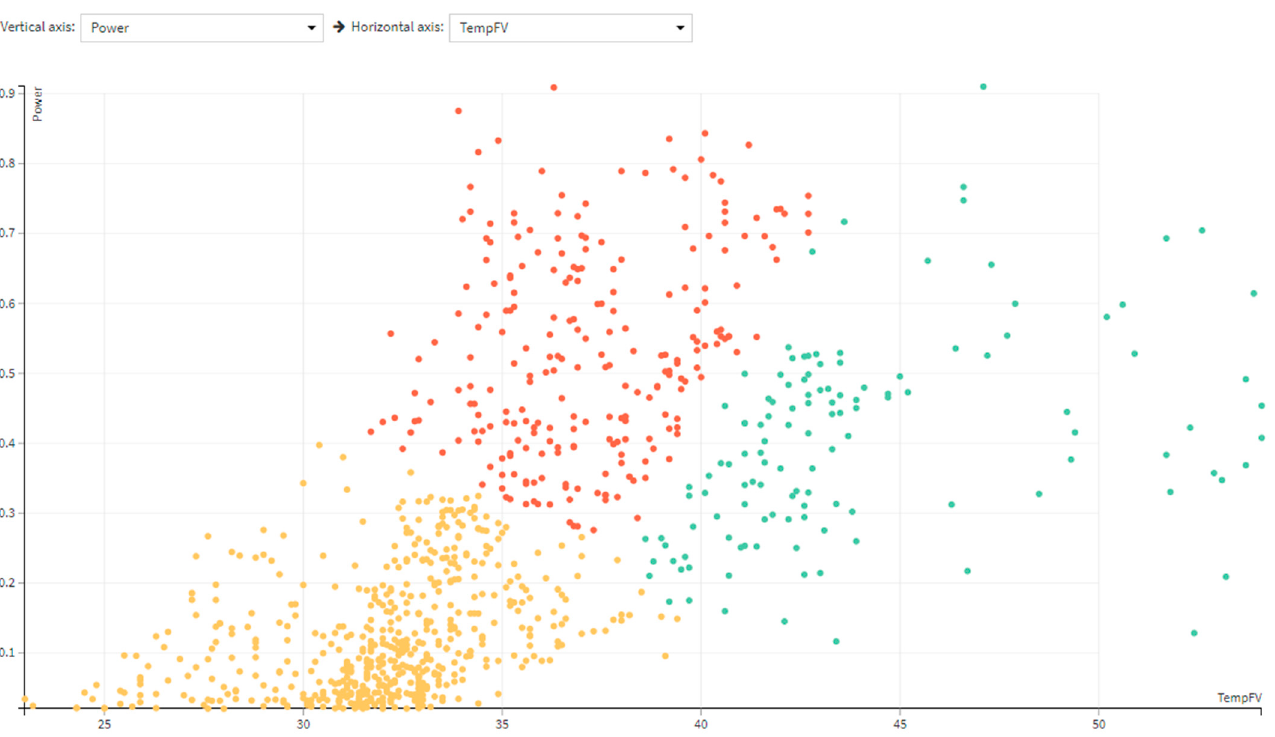
Figure 5. Data group scatter plot (KMeans 3).